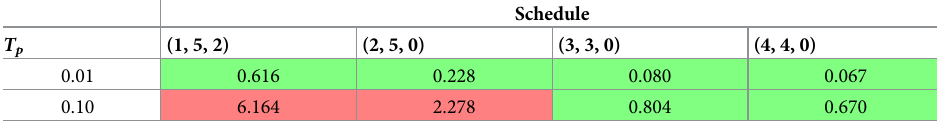
A green box indicates that the process eventually dies out, whereas a red box indicates continued